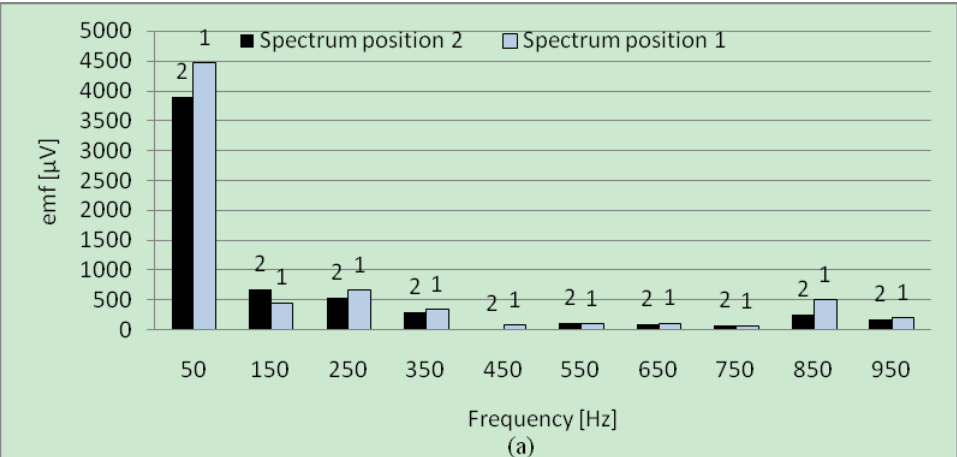
Figure 8. Frequency spectra for SSM at no-load operation for the two